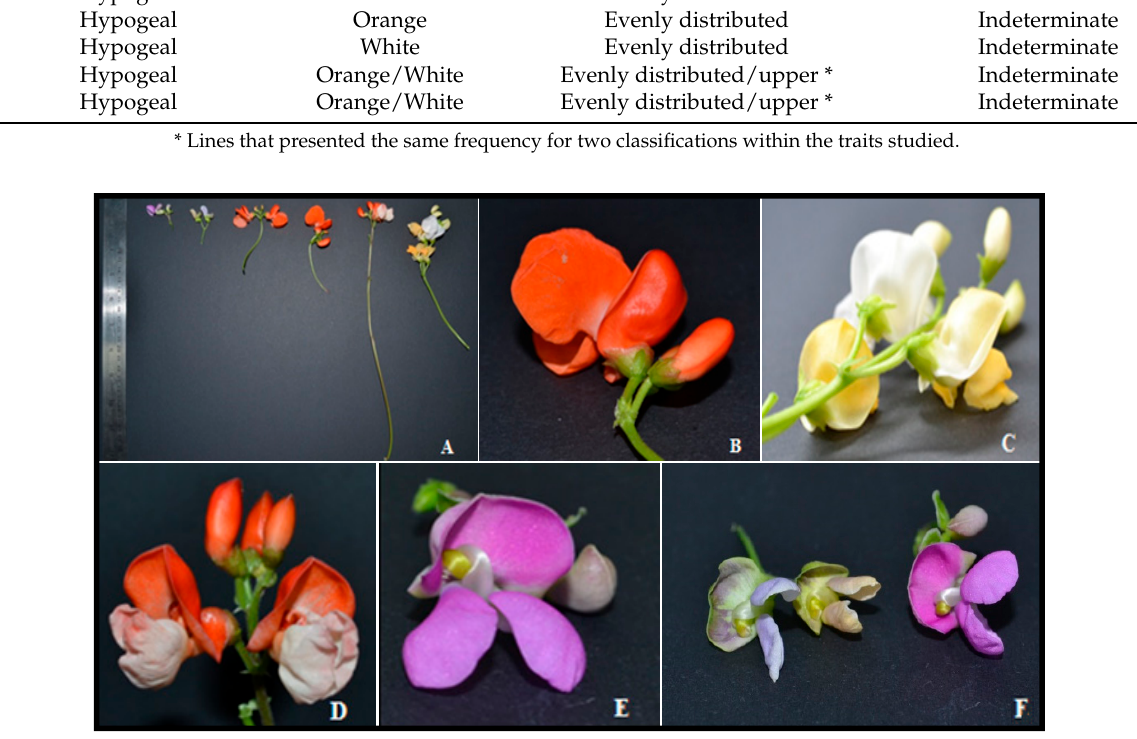
Figure 1. Morphology and colors present in the flowers of the ten Chilean lines of P. coccineus evaluated. ( A ) The different colors, petiole and flower size. ( B ) Orange flower morphology. ( C ) White flowers and the color change as the flower fades. ( D ) Color distribution in orange and white flowers. ( E ) Purple flower, and ( F ) similarity between the flowers of P. lunatus (left) and line 3 (right).